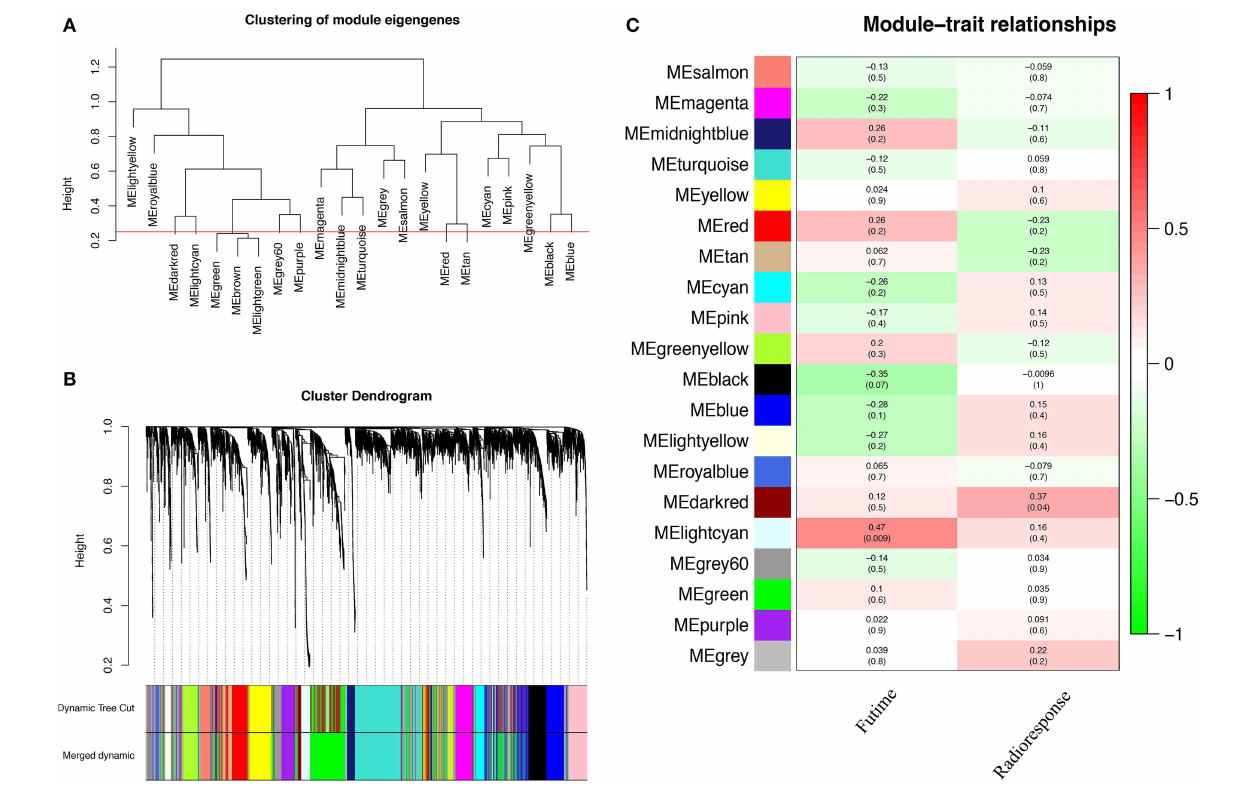
Frontiers in Oncology |